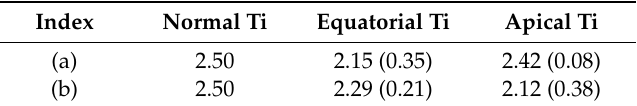
Figure 2. The numbers in parentheses give the difference of electron population of Ti around oxygen vacancy and normal grid Ti.